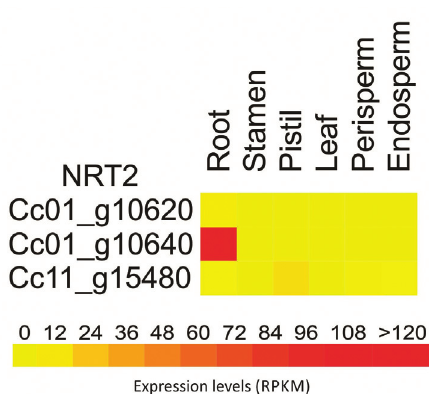
Figure 6 - In silico expression profile of C. canephora NRT2 gene family. RNAseq data from roots, stamen, pistil, leaves, perisperm, and endosperm were obtained from Coffee Genome Hub